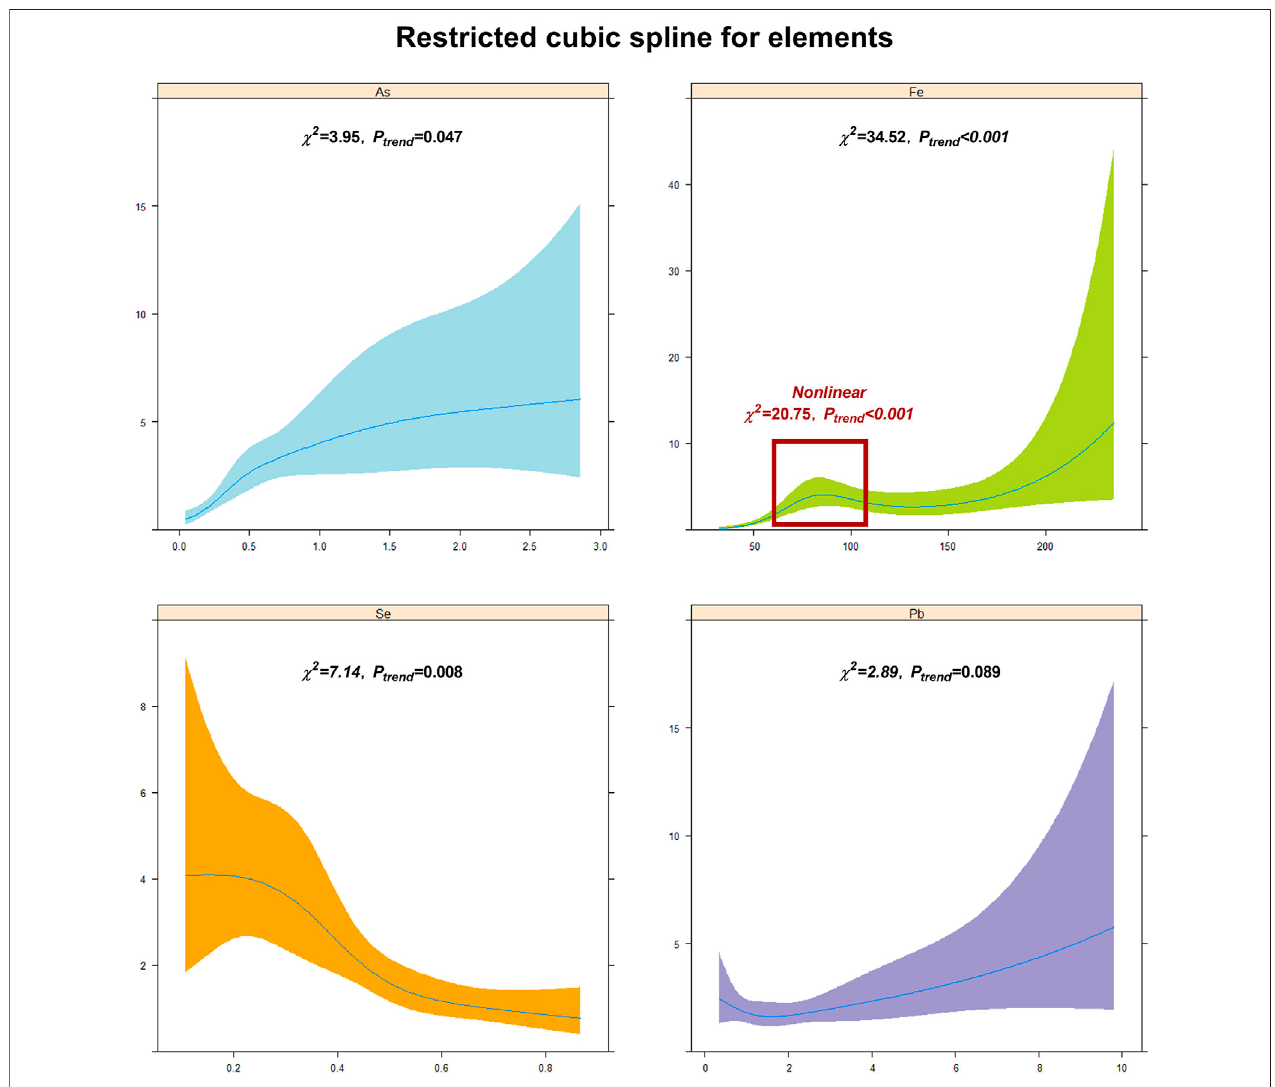
FIGURE3| Thelinearandnon-lineardose – responserelationshipsbetweenthecontentofAs,Fe,Pb,Se,andarsenism.Restrictedcubicsplinesareusedtoshow the linearandnon-lineardose – responserelationships betweenthecontentofAs,Fe, Pb, andSeand arsenism. Thered boxclearly shows thatthereisasigni fi cantnon- linear dose – effect relationship between Fe and